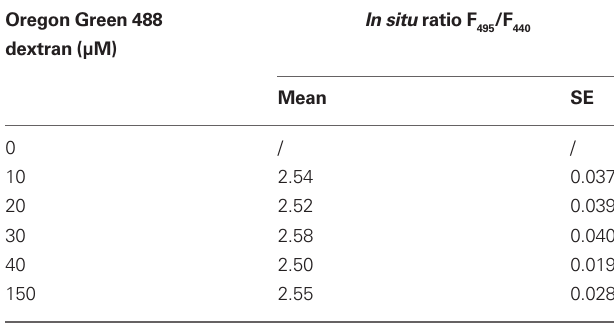
Table 1 | effects of various Oregon green 488 concentrations on the F F 440